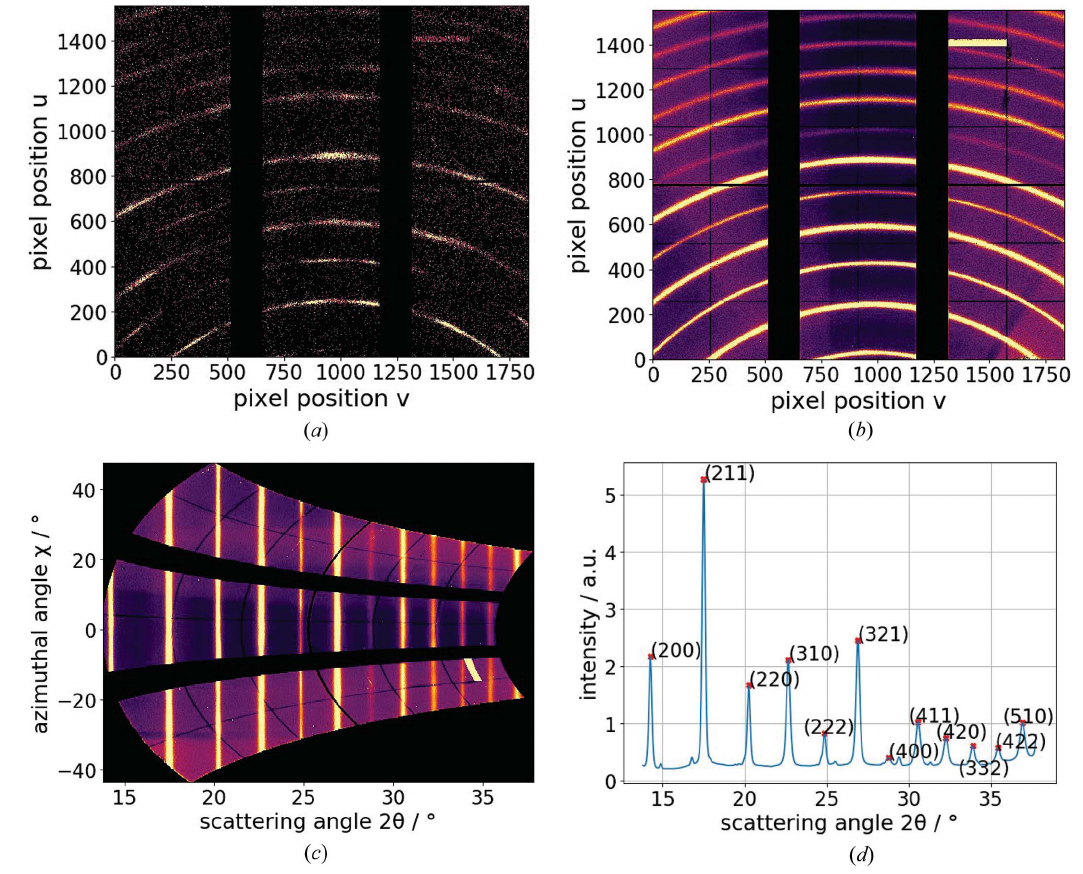
Figure 2 ( a ) A diffraction pattern of a single scan point of a martensitic steel sample. ( b ) A diffraction pattern of a martensitic steel sample summed over 2601 translation scan points. ( c ) Caking of the diffraction pattern in ( b ). ( d ) Final azimuthal integration of ( c ) yielding the 2 (cid:2) positions of martensitic diffraction peaks. The yellow stripes in the upper right of ( b ) and the lower right of ( c ) are